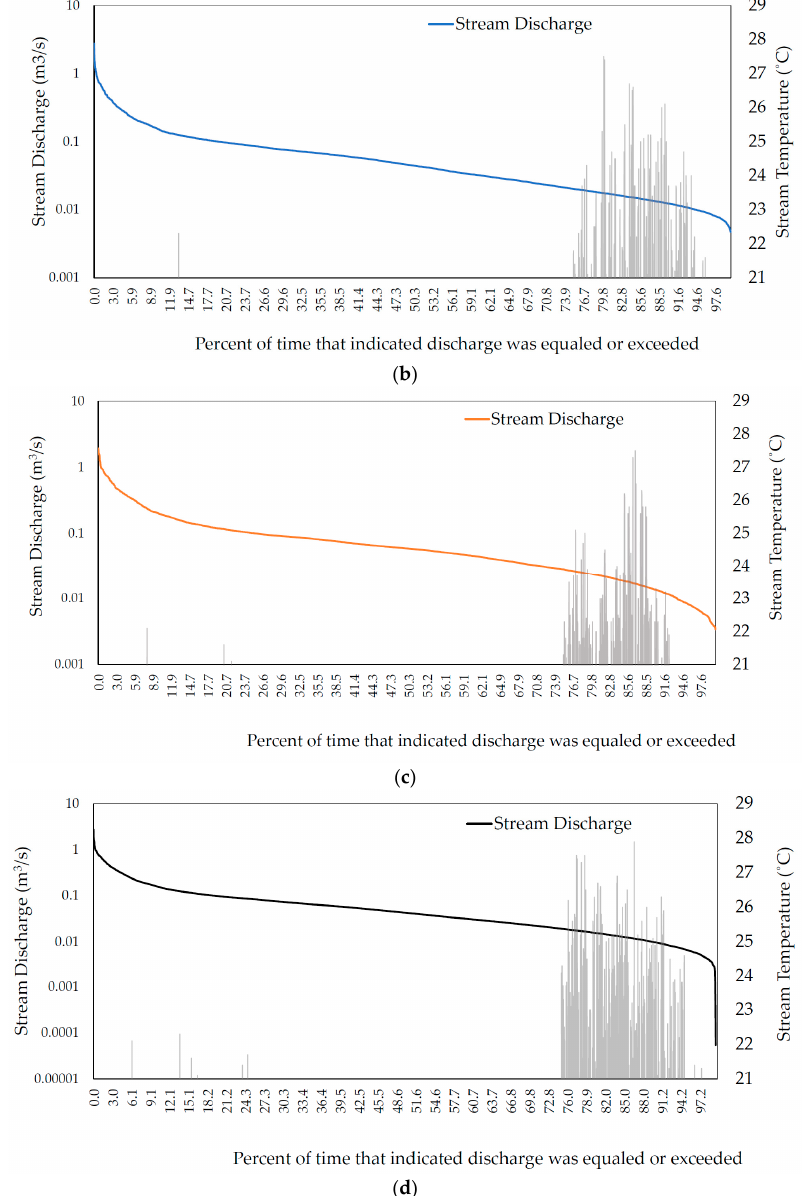
Figure 6. Cork Brook simulated flow duration curve and stream temperatures for SWAT with the hydroclimatological component over three decades. ( a ) 1980–1989, ( b ) 1990–1999 ( c ) 2000–2009 and ( d ) 1980–2009. The secondary y -axis begins at 21 °C and any temperatures that are not above the stressful threshold are not shown in the figures. The stream temperatures in the Q25–Q75 range are omitted from each figure.